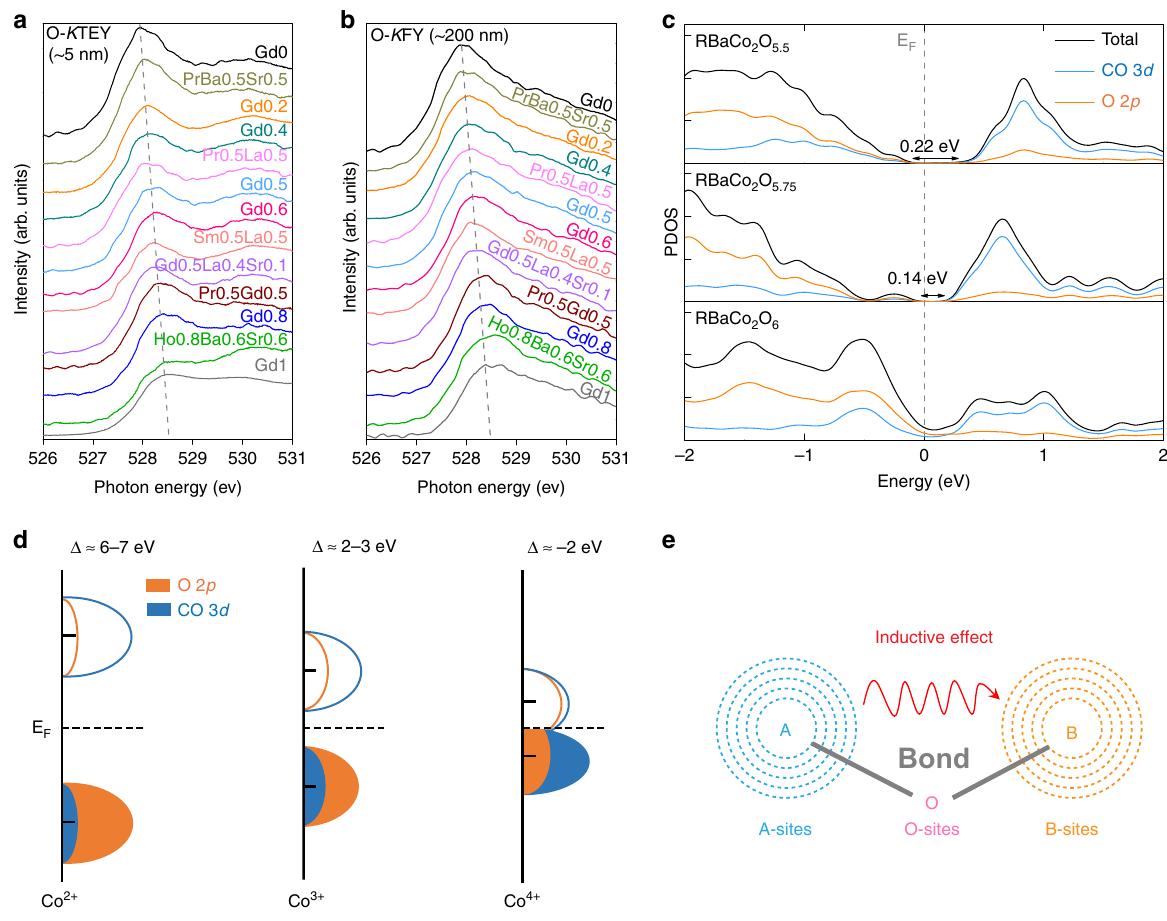
Fig. 4 Association with electronic structures. Soft XAS spectra at O- K edge collected in a TEY and b FY modes for all perovskites studied here. c PDOS calculations of Co 3 d and O 2 p orbitals for Co 3 + (RBaCo 2 O 5.5 ), Co 3.25 + (RBaCo 2 O 5.75 ), and Co 3.5 + (RBaCo 2 O 6 ). d Charge-transfer models of Co 2 + , Co 3 + , and Co 4 + in covalent systems. e Inductive effects and electron exchange interactions between A-sites and B-sites in perovskites from molecular orbital